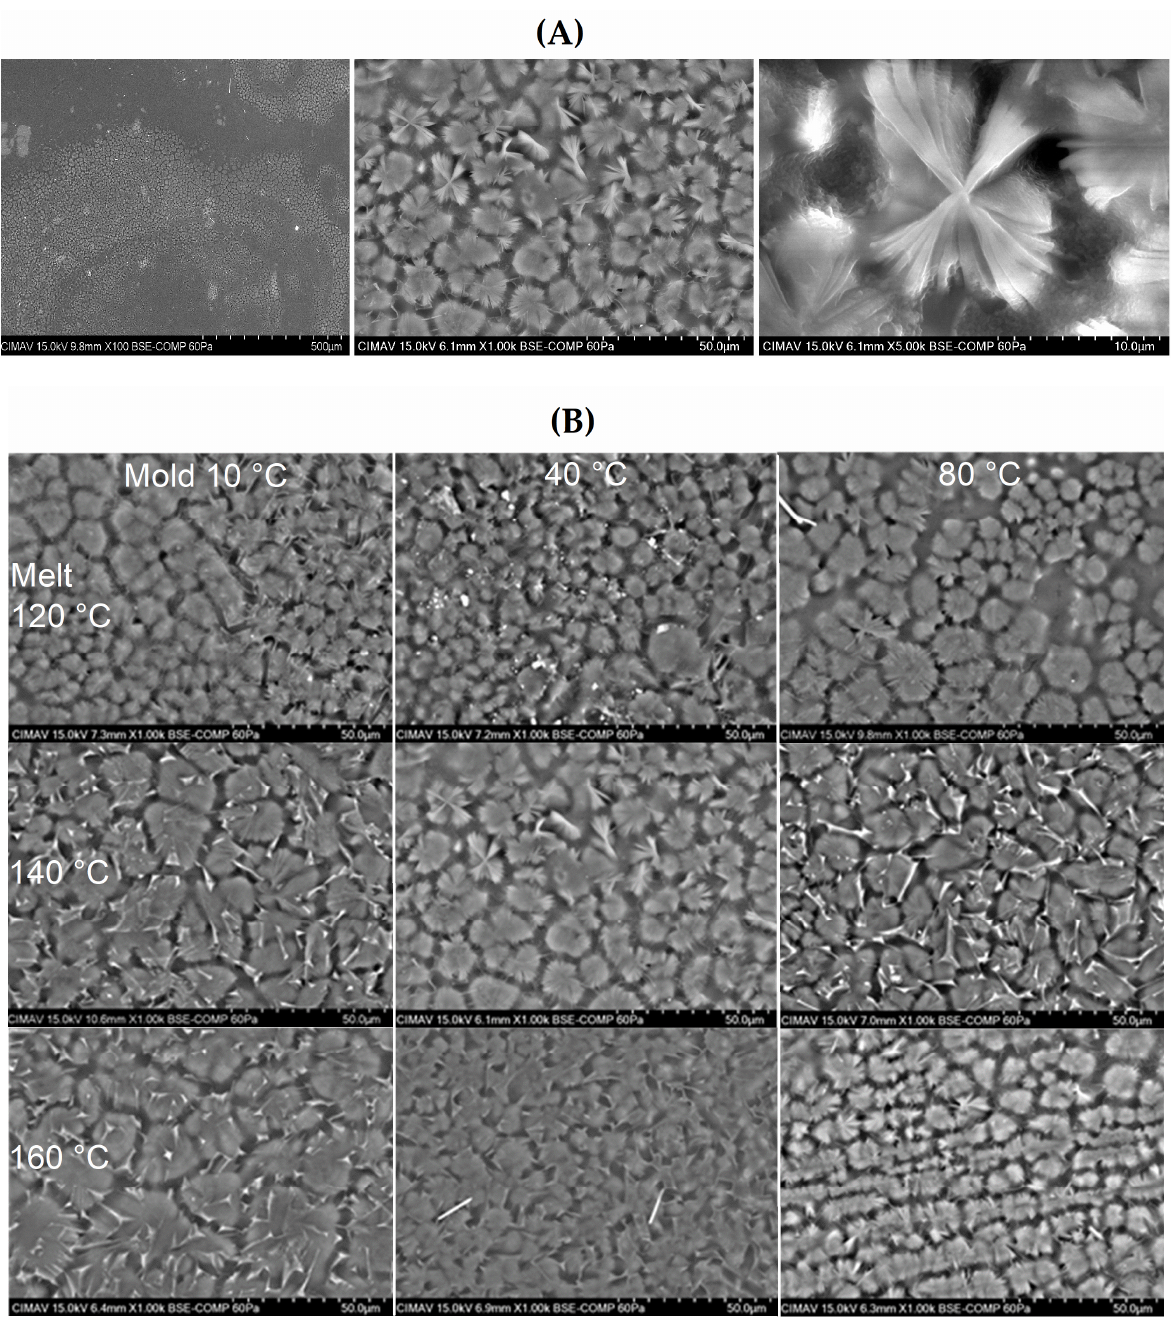
Figure 1. (A) Micrographs at different magnifications of the surface of a sample where spherulites were found. (B) Representative micrographs at 1000x of the spherulites of LDPE injection-molded specimens.